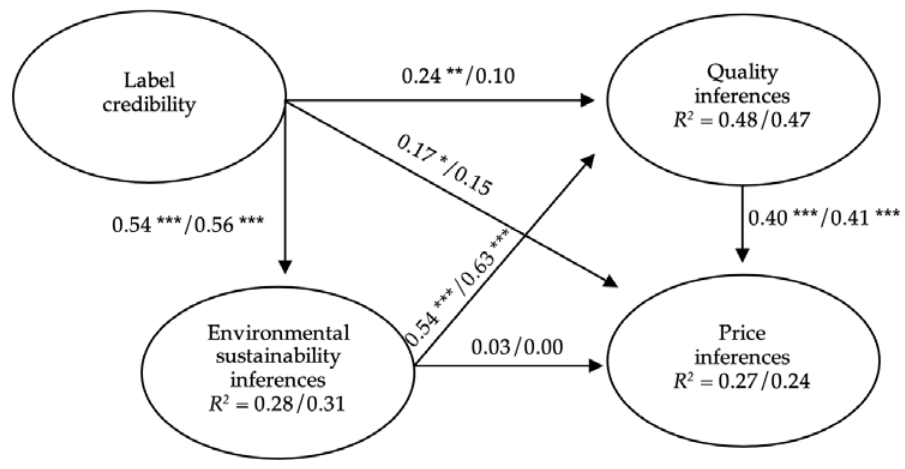
Figure 3. Structural model for the PGI label (non-information/information). Note. * p <